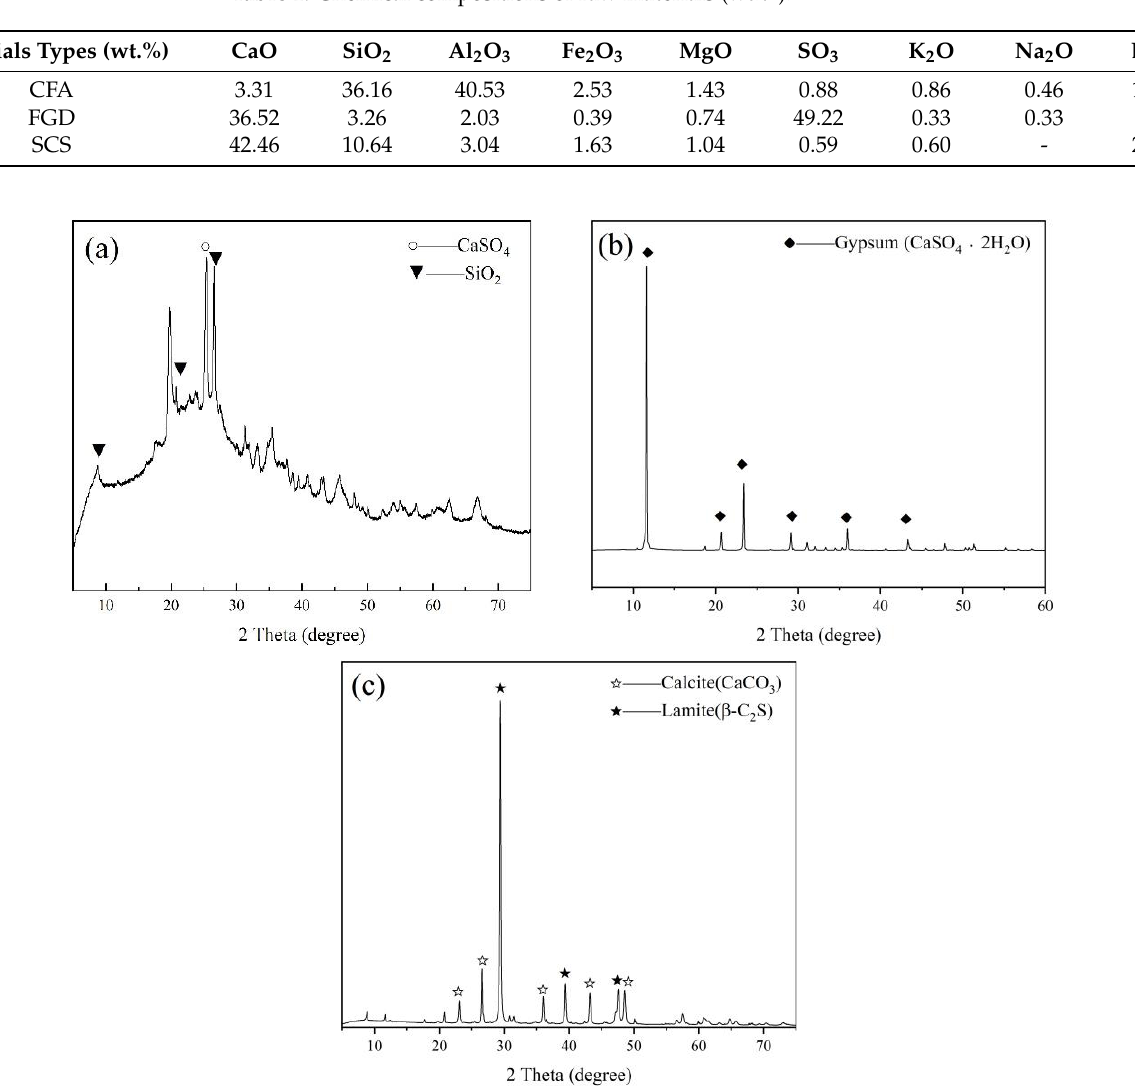
Figure 3. Phases identified by XRD method in examined samples: ( a ) CFA; ( b ) FGD; and ( c ) SCS.